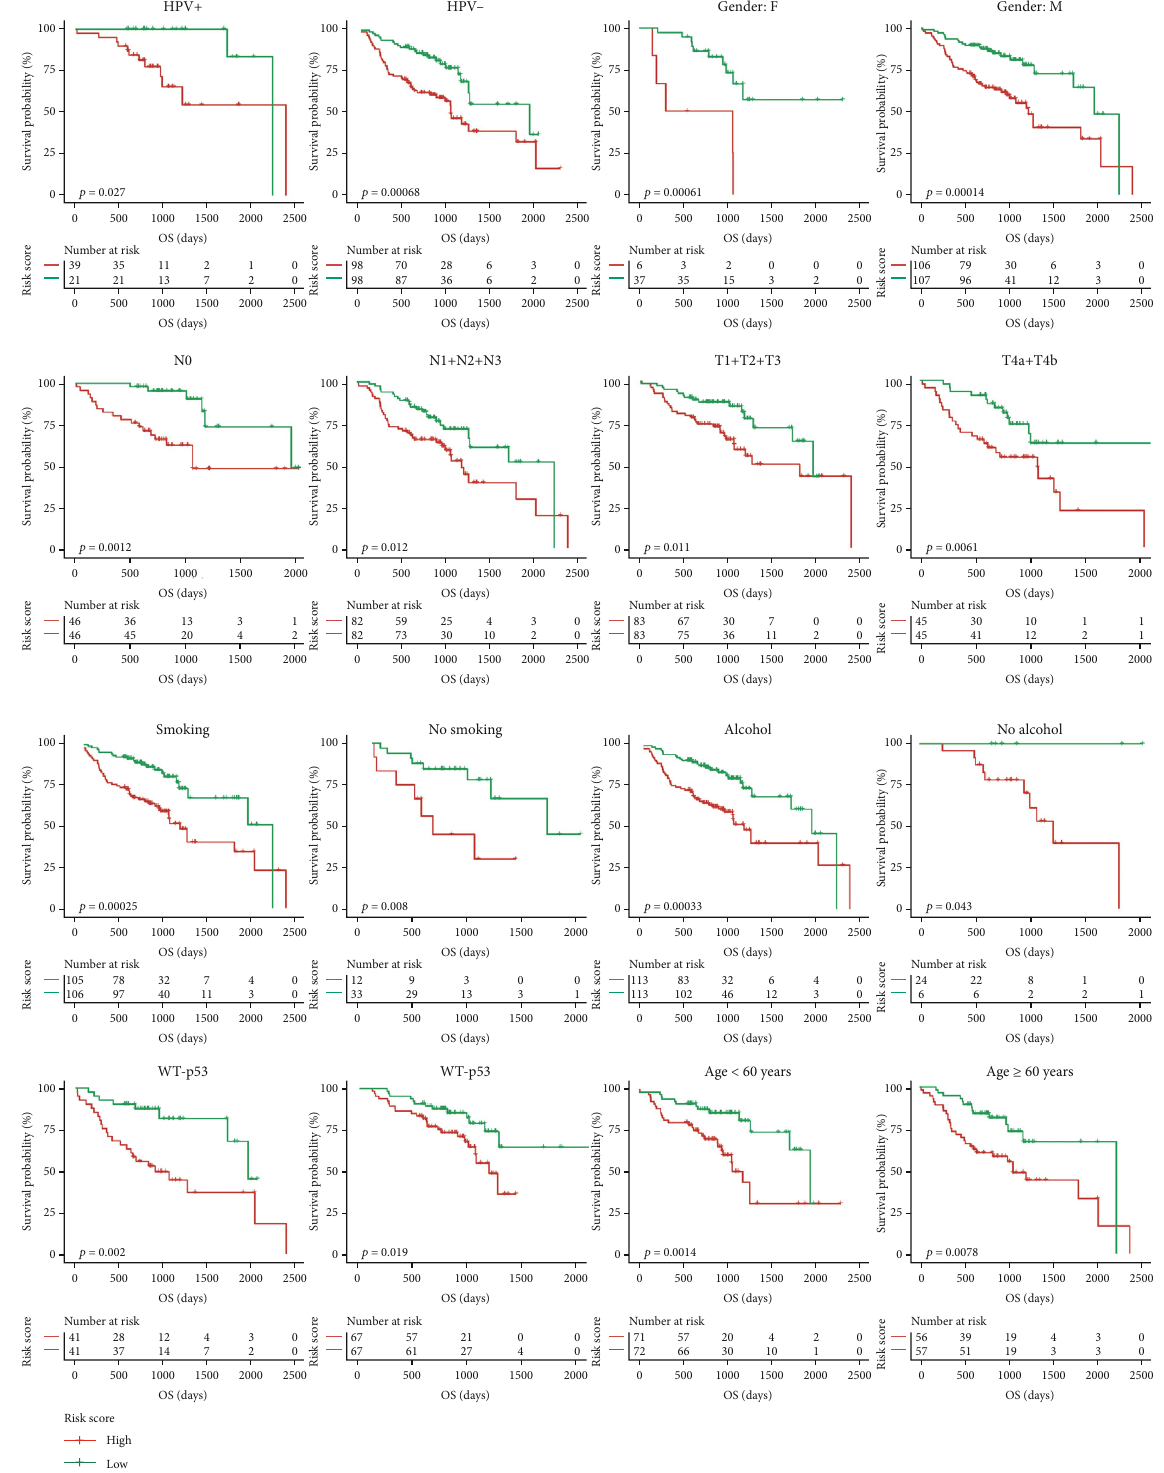
Figure 7: E ff ects of di ff erent clinical characteristics on the prognosis of HNSCC patients. Based on the risk score of 256 HNSCC patients in the GSE65858 dataset calculated by the prognostic evaluation model, patients were divided into high- and low-risk groups after fi rst being strati fi ed by clinical features such as HPV infection, sex, lymph node metastasis, degree of tumor in fi ltration, smoking, alcohol consumption, TP53 gene mutation, and age. All these features had an impact on the prognosis of HNSCC